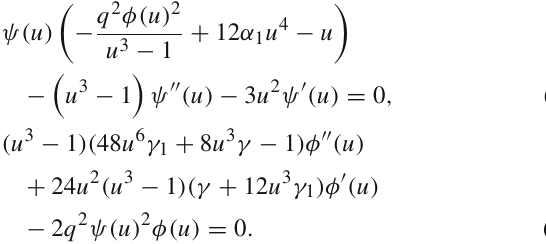
√ (cid:9) O (cid:10) / T c as a function of the temperature 2 (cid:16) − 4 q 2 A μ ψ 2 = 0 ,